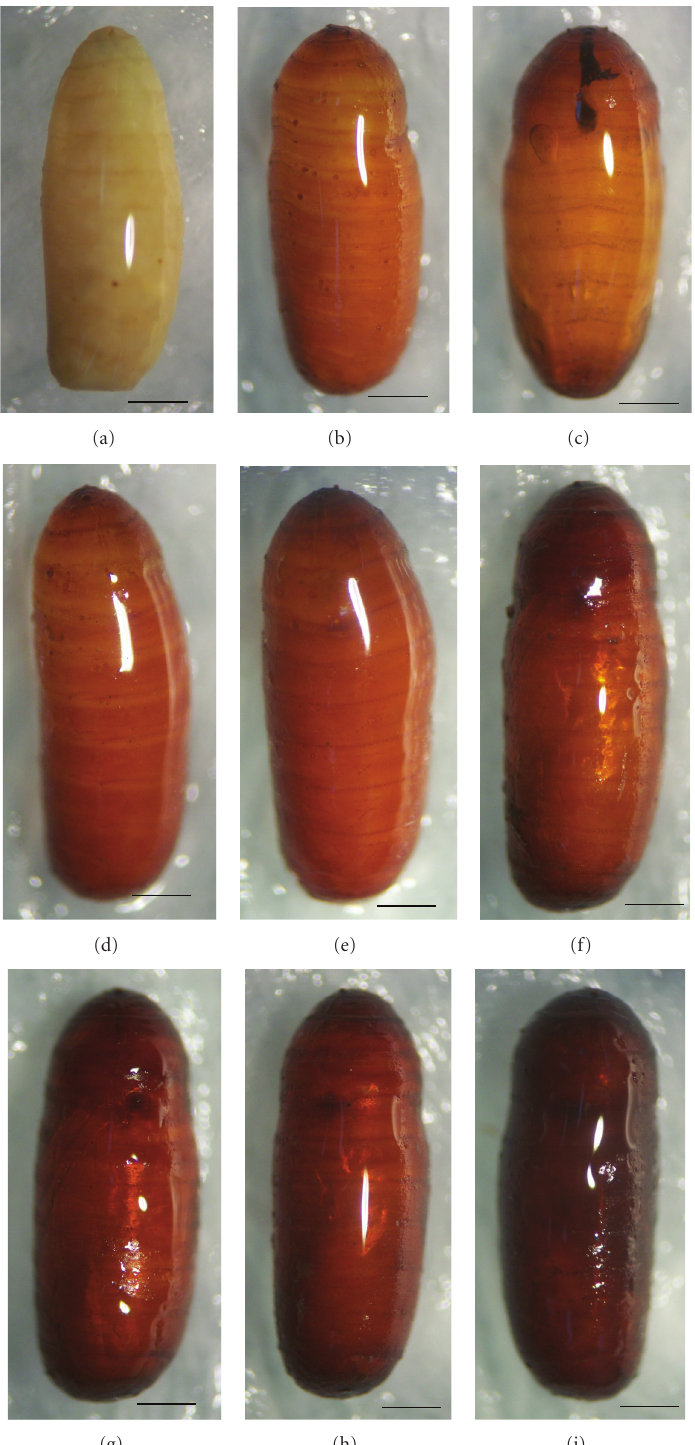
Figure 3: Color changes in puparia of Hemipyrellia ligurriens up to 24h after pupariation. Puparium (a)–(i) at 0, 3, 6, 9, 12, 15, 18, 21, and 24h, respectively. Bars = 100 µ m for all